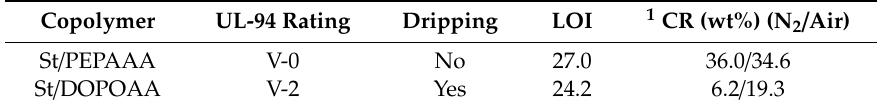
Figure 22. Synthesis route of 1-oxo-2,6,7-trioxa-1-phorsphabicyclo [2,2,2]oct-4-yl methyl acrylate (PEPA-AA) [114]. Table 1. Comparative data of PS/PEPA-AA and PS/DOPOAA (DOPO–methylacrylate) copolymers